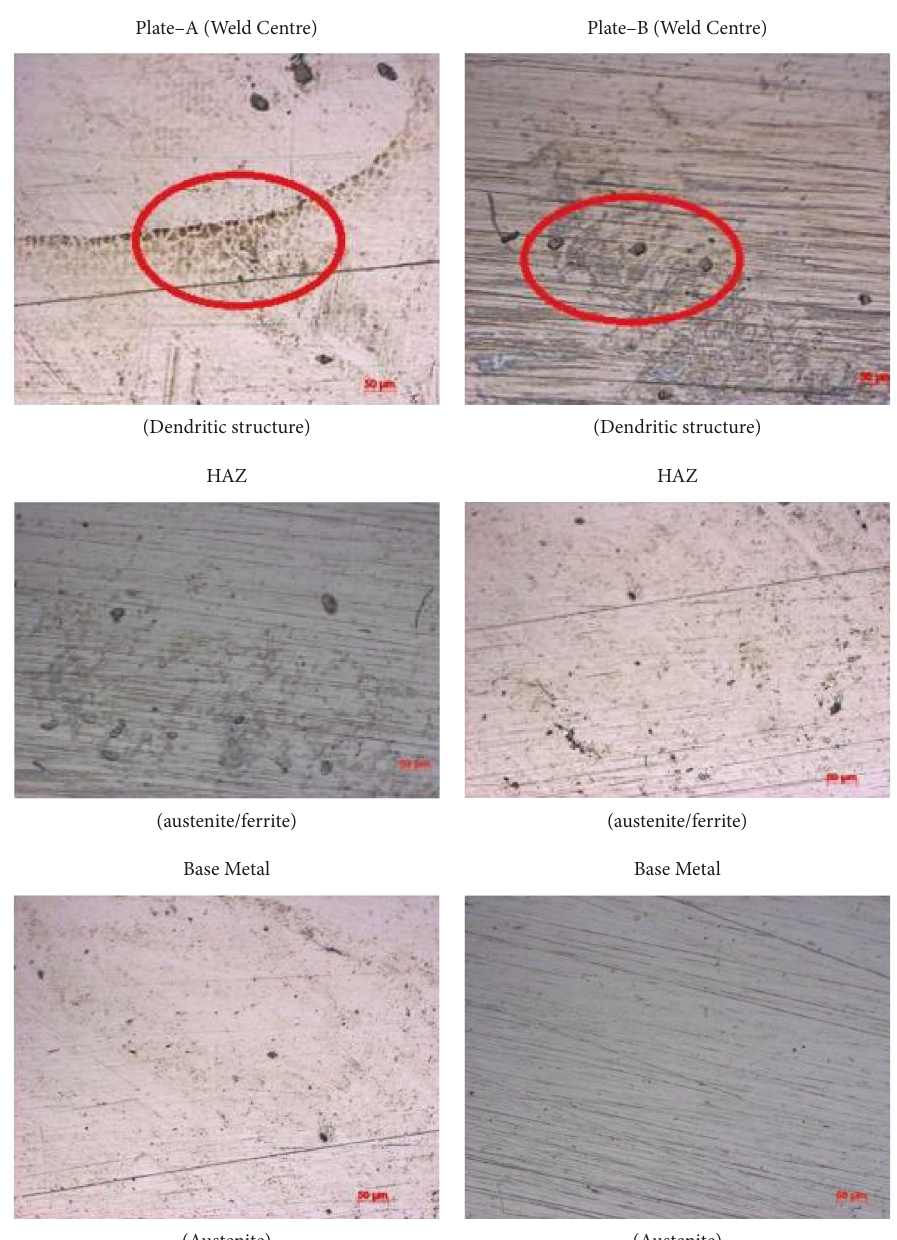
Figure 13: Microstructure analysis of welded specimens.